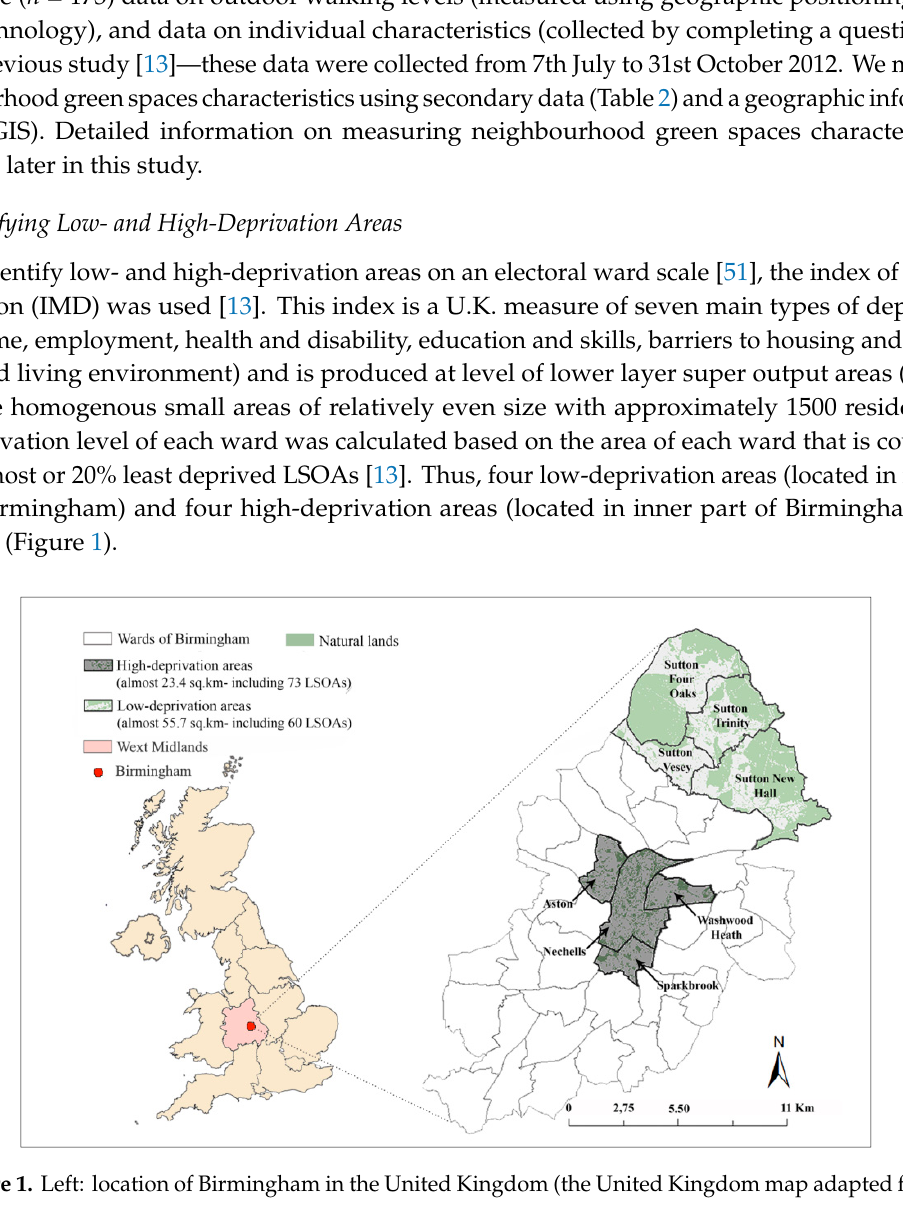
Figure 1. Left: location of Birmingham in the United Kingdom (the United Kingdom map adapted from the work of[53]); right: locations of low- and high-deprivation areas in Birmingham. Adapted from the work of